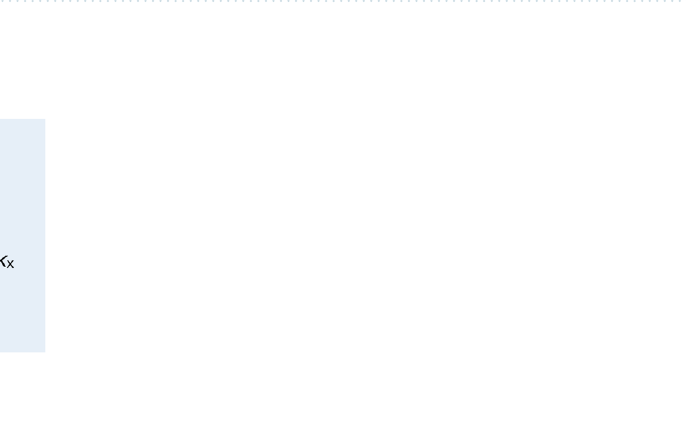
Figure 4. The kinetic scheme of non-essential mixed type activation and rate constants (Baici, 2015). The k 1 , k 2 , k 3 , k 4 , and k 5 are rate constants, and the unit with k 2 , k 3 , and k 5 in s −1 , and the unit of k 1 and k 4 in M −1 s −1 . The corresponding dissociation constants K S and K X , in M, equal k 2 / k 1 and k 5 / k 4 , respectively. The Michaelis–Menten constant K m equals ( k 2 + k 3 )/ k 1 with units of M. The catalytic constant k cat ( k 3 ) is in s −1 . α and β are dimensionless positive coefficients. K Sp and K Ca refer to the specific (competitive) and catalytic (uncompetitive) modifications, respectively. The catalytic efficiency k cat / K m of the enzyme is used for comparing the relative rates of enzyme activity acting on the substrate with or without